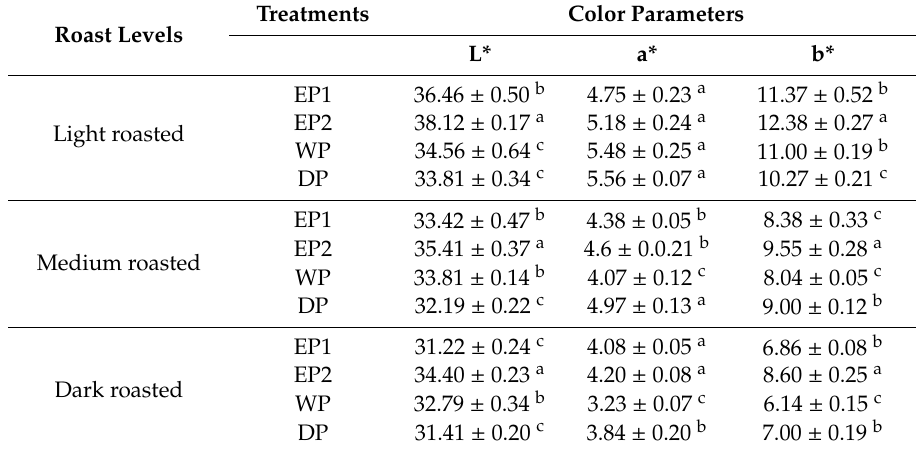
Table 1. Colorimeter data of roasted co ff ee that obtained using di ff erent processing